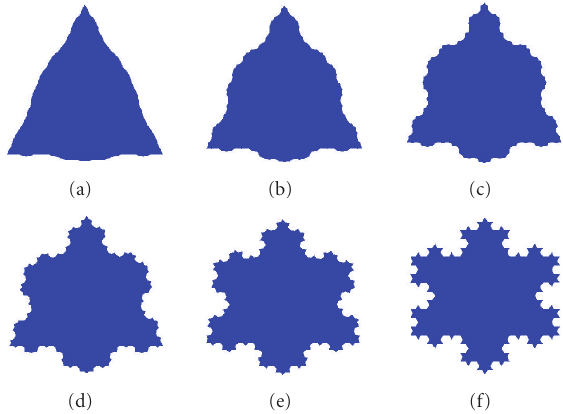
Figure 3: Third iterated Koch fractal boundary microstrip anten- nas with indentation angles (a) 10 ◦ , (b) 20 ◦ , (c) 30 ◦ , (d) 40 ◦ , (e) 50 ◦ , and (f) 60 ◦